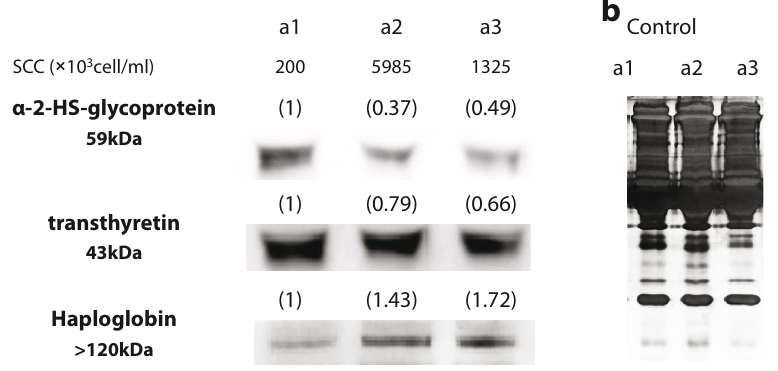
The DEPs was validated by western blot. (a) The representative image of DEPs. The values in parenthesis are the relative normalized intensities compared to those in healthy cows. (b) The internal control was indicated by the 2-DE gels using 1 µL total plasma